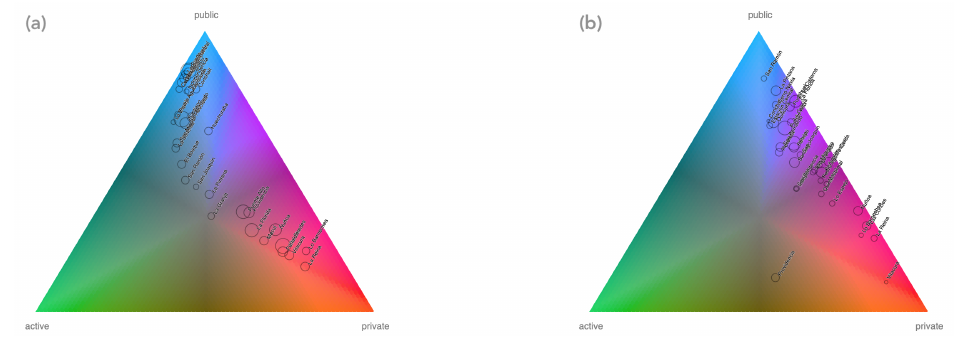
Figure 10. XDR ( a ) and survey ( b ) flows aggregated by origin municipality positioned on the ternary plot according to mean trip mode split (also encoded by background color), with radius encoding total